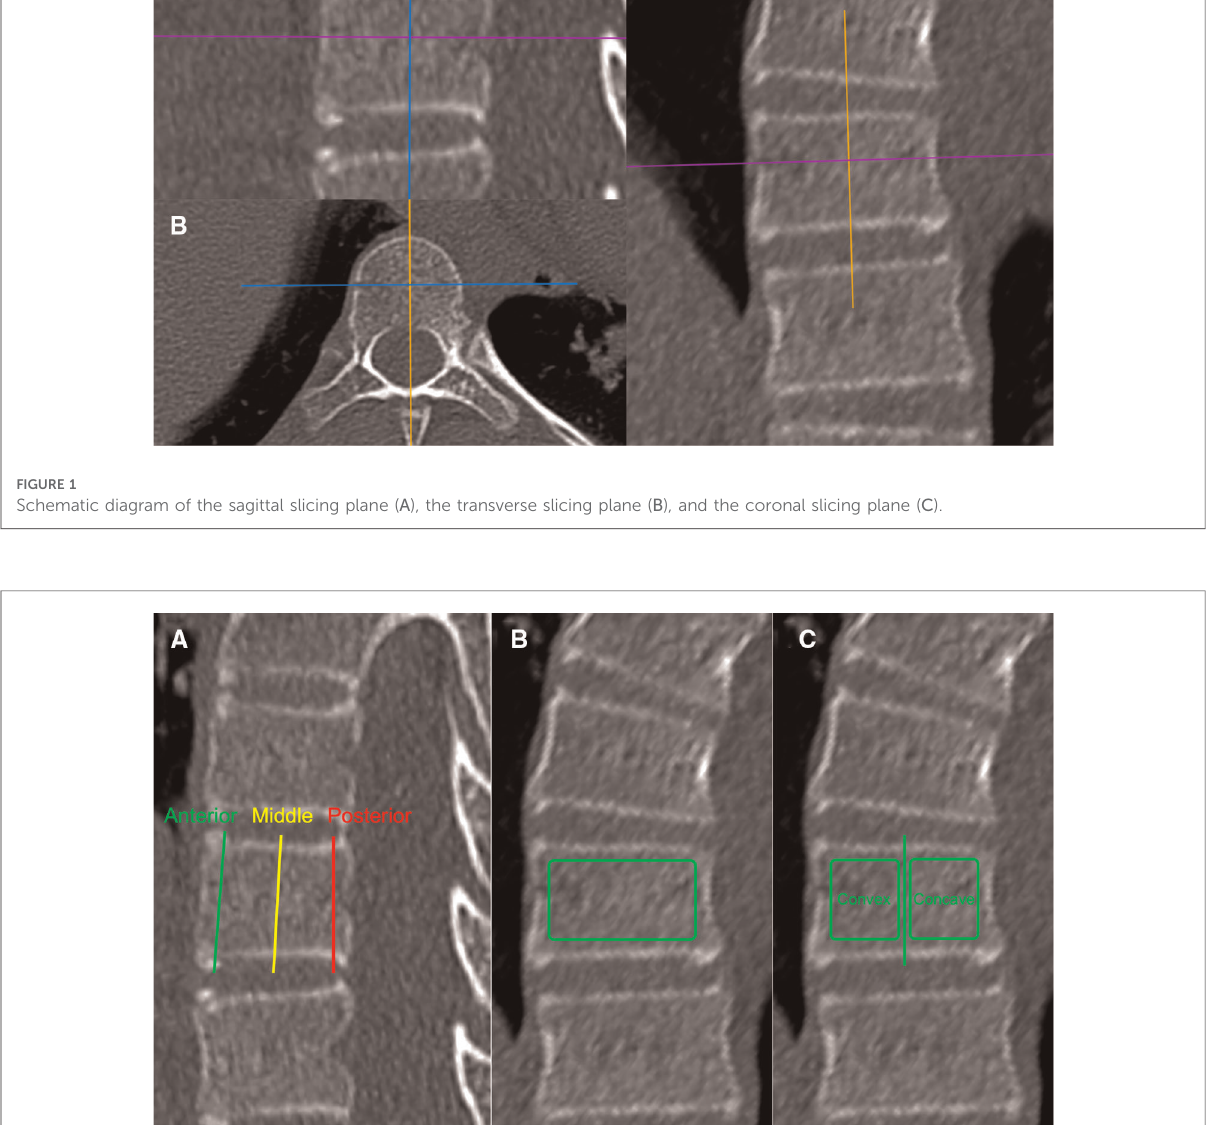
the VB-HU and PST-HU at the apex, UEV, and LEV were measured. All parameters were measured by two independent observers and averaged for statistical analysis. The asymmetric ratios of VB-HU and PST-HU were calculated by HU values within the concave side/HU values within the convex side.